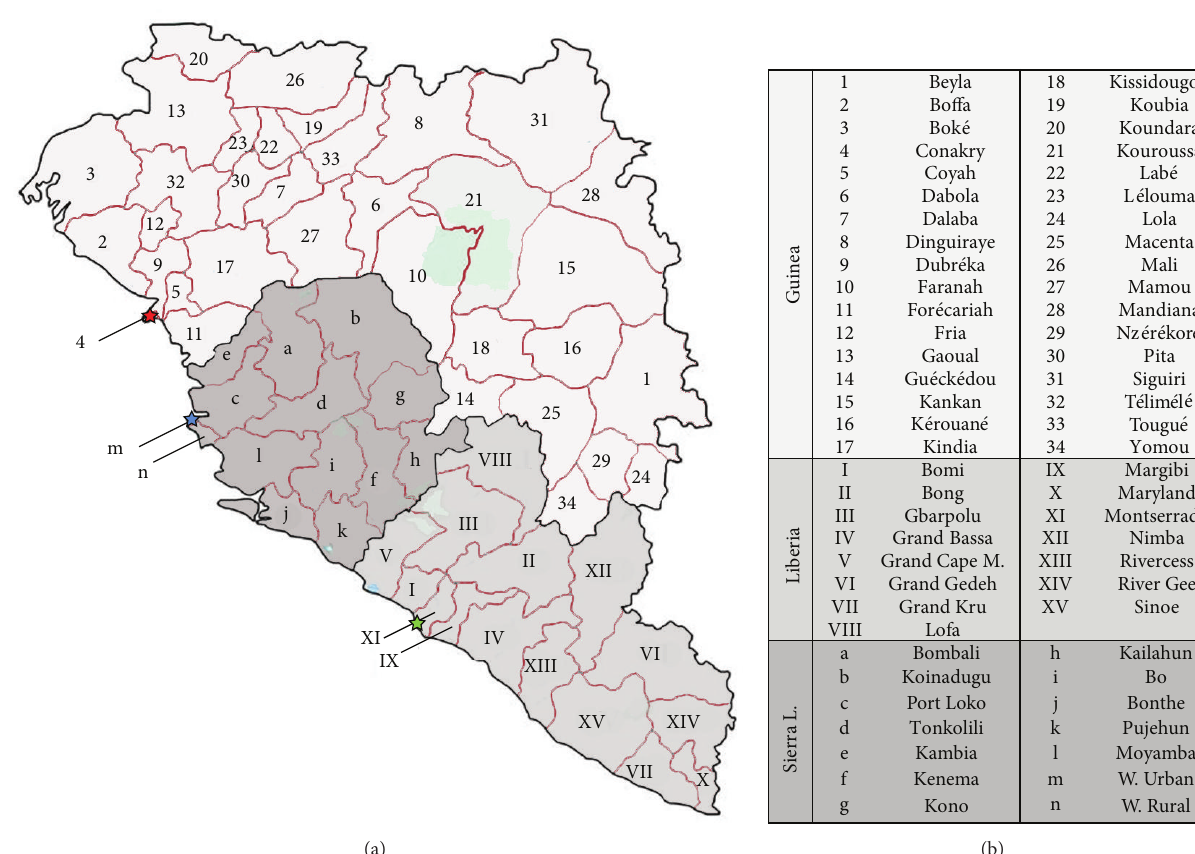
Figure 4: (a) Affected nations (Guinea, Liberia, and Sierra Leone) divided in the respective administrative areas. Guinea, light grey, 34 prefectures, numbers from 1 to 34; Liberia, 15 countries, mild grey, Roman numerals from I to XV; Sierra Leone, dark grey, 14 districts, letters from a to n. Stars indicate the capital cities; red star, Conakry; green star, Monrovia; blue star, Freetown. (b) In the panel the regions in which each country is suborganized are